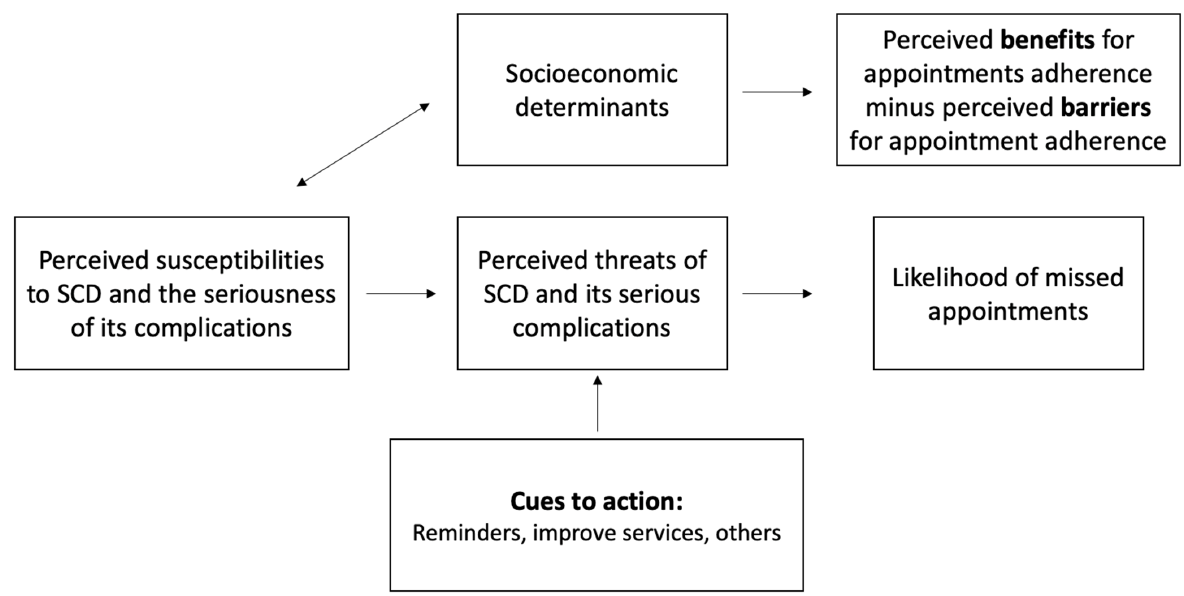
Figure 1. Health belief model for missed appointments.